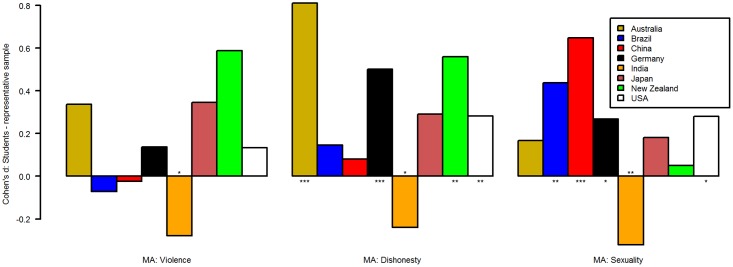
Cohen's d of student—general public comparisons for moral attitudes (MA).See text for explanation. *p < .05, **p < .01, ***p < .001.